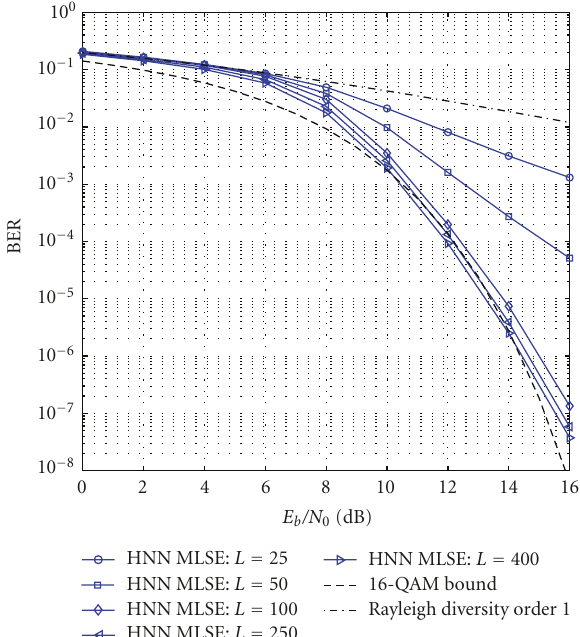
Figure 15: 16-QAM HNN MLSE equalizer performance in extremely long channels.